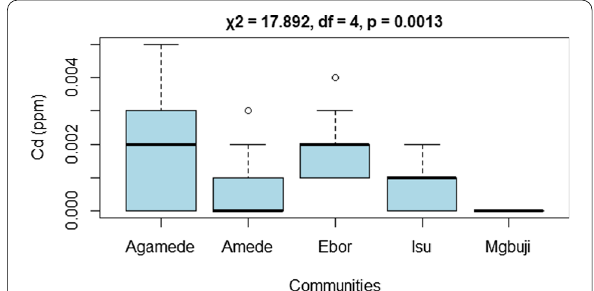
Fig. 3 Comparison of bioaccumulation of Mn in Achatina spp amongst sampled communities